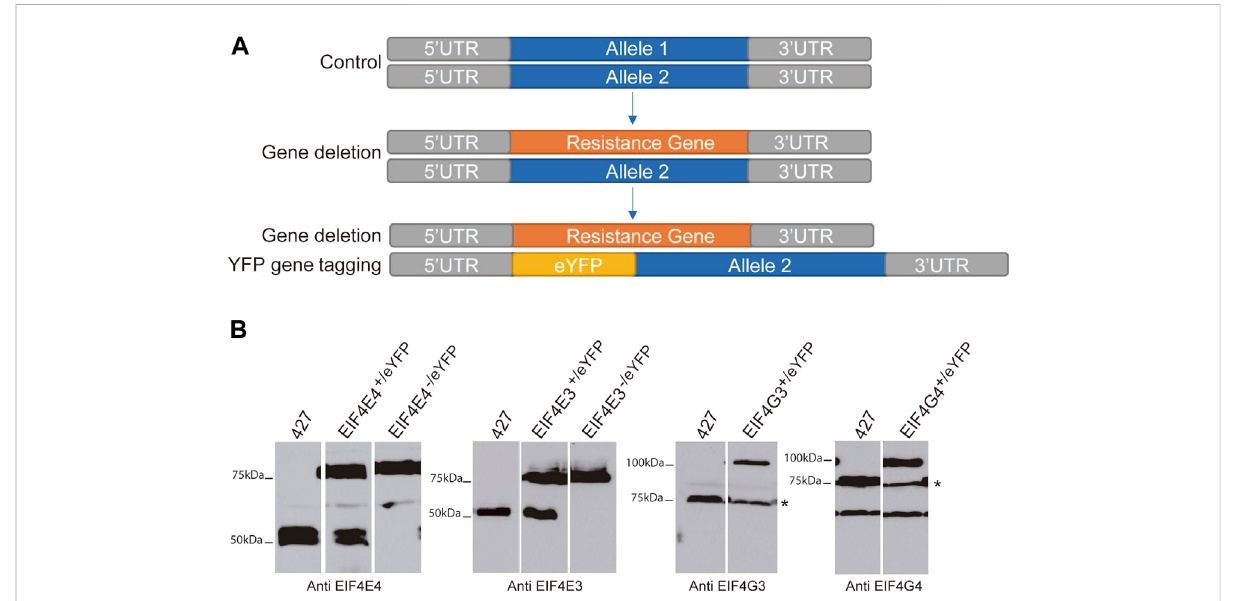
FIGURE 1 Expression of eYFP-tagged EIF4E3, EIF4E4, EIF4G3 and EIF4G4 proteins. (A) Representative scheme of eYFP-tag addition in target genes. (B) Immunodetection of the four eYFP-tagged proteins using cytoplasmic extracts from the various T. brucei cell lines generated as well as from cells lacking eYFP-tagged proteins (427 — Lister 427 procyclic cells). The asterisk for the eIF4G blots indicates the endogenous EIF4G3 and EIF4G4 bands. ForEIF4G4,anon-speci fi cbandoflowermolecularweight,aproductofcross-reactionwith theantibodies used, isalso seen.Alltheseparated lanes shown in the different panels are from the same blot and with the same exposure. Numbers on the left indicate the sizes of molecular weight markers (in